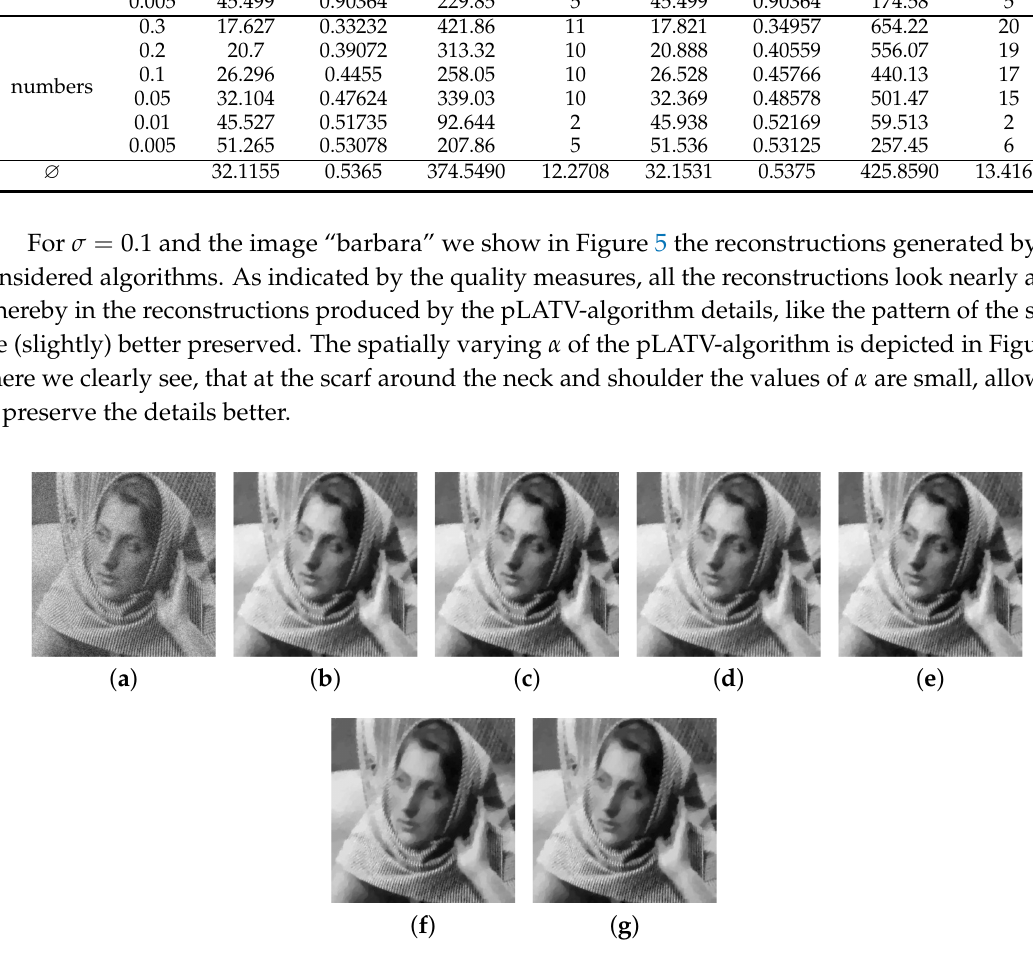
Figure 5. Reconstruction from blurry and noisy data. ( a ) Noisy observation; ( b ) pAPS with